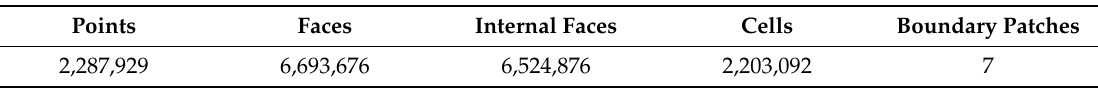
Figure 2. Reconstruction of the Stereo Lithography (STL) surface ( a ); and bottom layer of the computational mesh ( b ). Table 1. Characteristics of the final mesh: number of points, number of total and internal faces, number of cells and number of boundary patches.